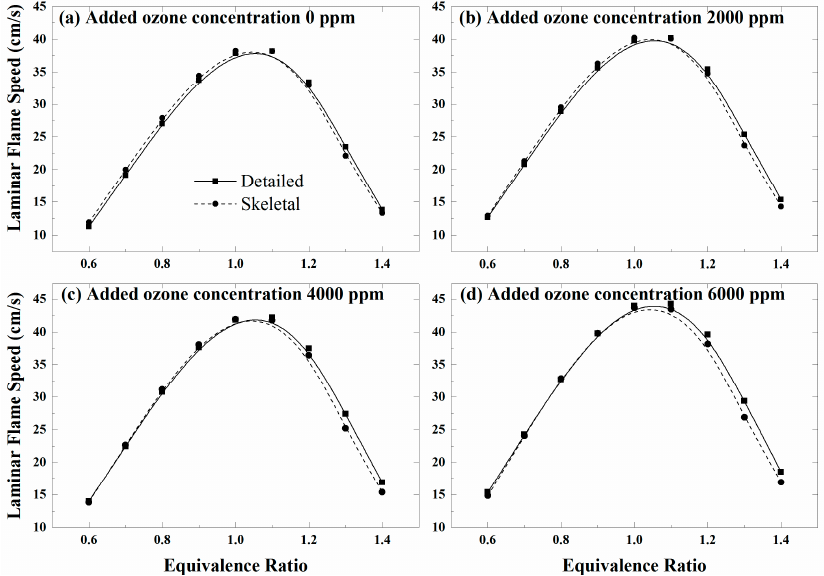
Figure 4. Predicted laminar flame speeds of cases with different ozone additions (The speeds were calculated using the detailed mechanism and skeletal mechanism).